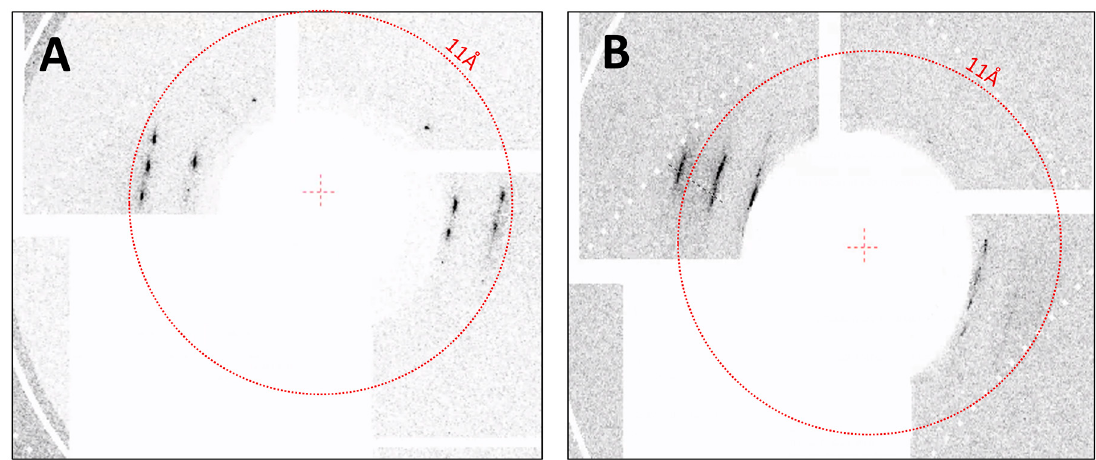
Figure 4. An example of hits collected at MFX for S816-4 ApoA1 at MFX showing ( A ) anisotropic diffraction and diffuse features at 4.2 Å, and averaging of signal intensities along ( B ) layer lines and ( D ) an orthogonal crystallographic axis. The equivalent histograms of the reflection spacing measured from ( B ) and ( D ) are shown in ( C ) and ( E ), respectively.